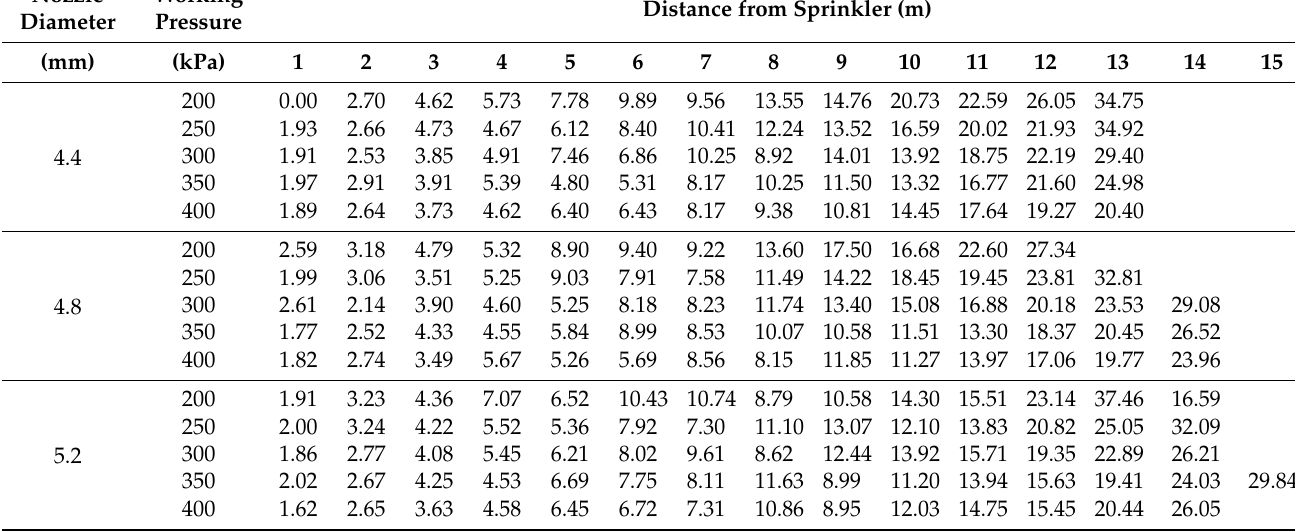
Table 2. Kinetic energy per unit droplet volume (J L − 1